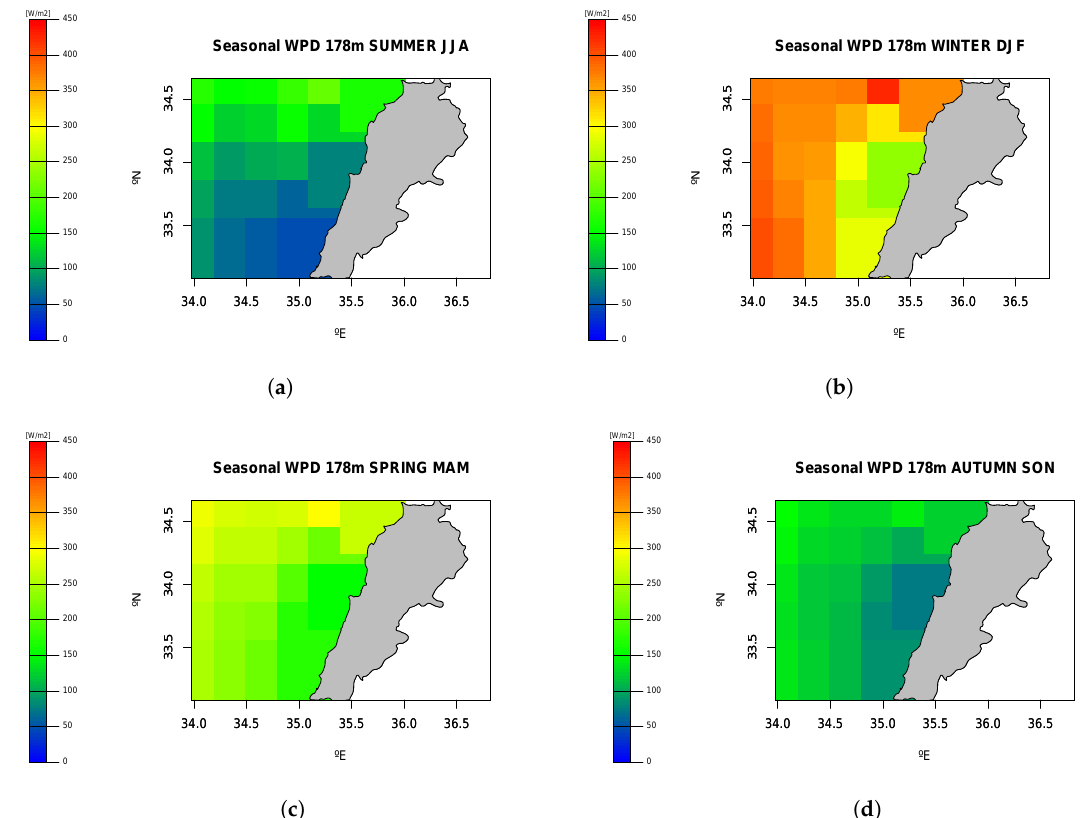
Figure 6. wind power density at 178 masl. WPD 178 . ( a ) Summer. ( b ) Winter. ( c ) Spring. ( d ) Autumn.